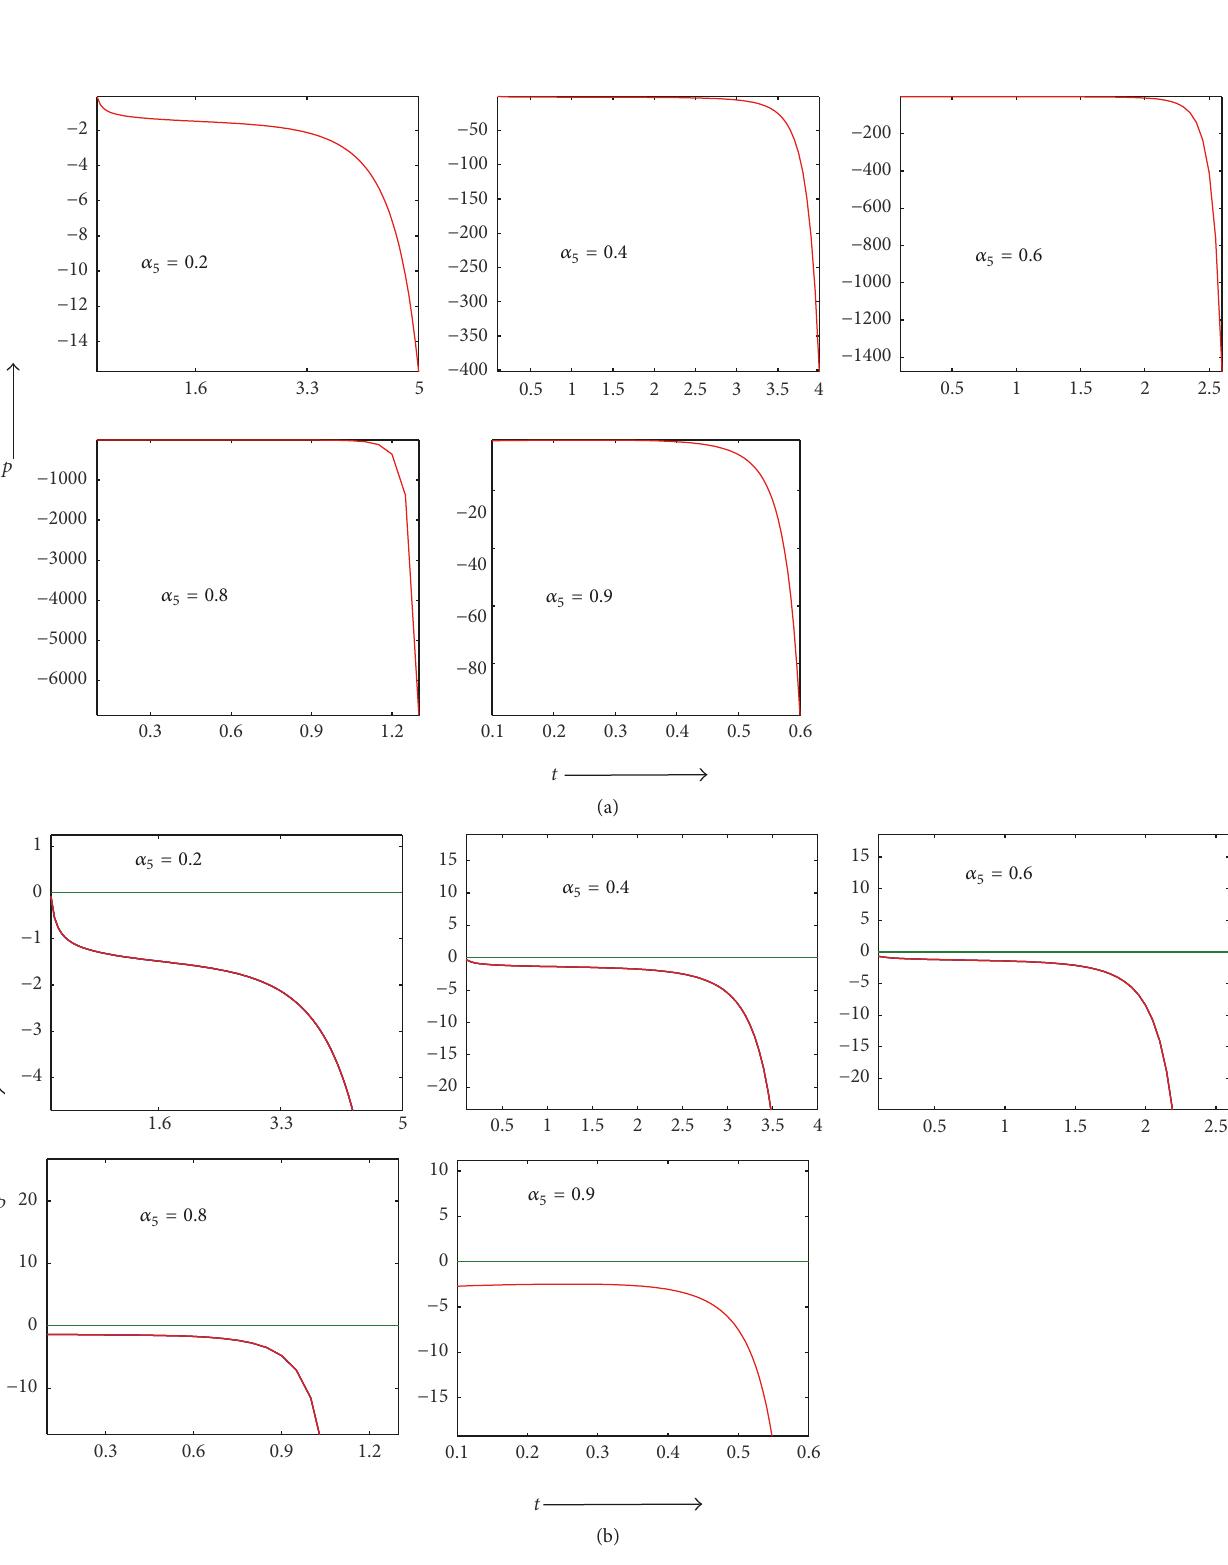
Figure 22: Variation of pressure 𝑝 against time for 𝛼 1 = 0.5 , 𝐴 = 1 , 𝐵 = 1 , 𝑛 = 0.1 , 𝜔 = 1 , 𝜙 0 = 1 , 𝑐 2 = 0.1 , and different 𝛼 5 . (b) shows the zooming of